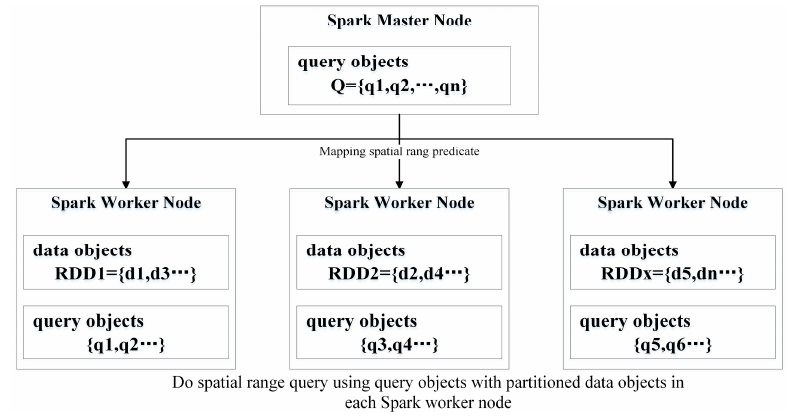
Figure 1. The execution flow of Spark-based spatial range query (SRQ) algorithms. The partitioned spatial data objects are spatial resilient distributed datasets (RDDs). Spark executors on Spark worker nodes would do spatial range predicate computation after the mapping transformation tasks are received from the Spark Master instance.